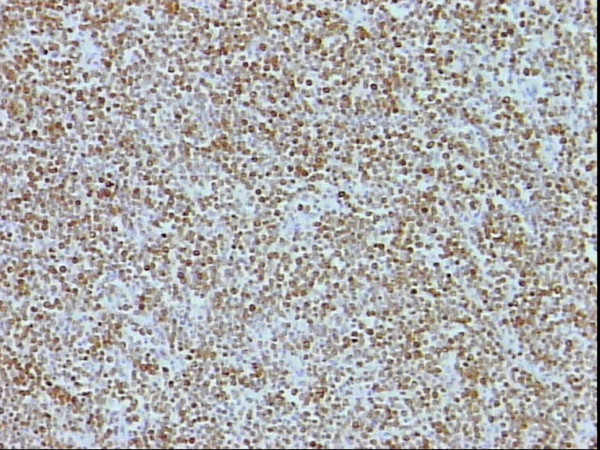
High proliferation fraction as noted by the staining of up to 75% of the neoplastic lymphocytes, MIB-1, DAB, Hx, × 10.